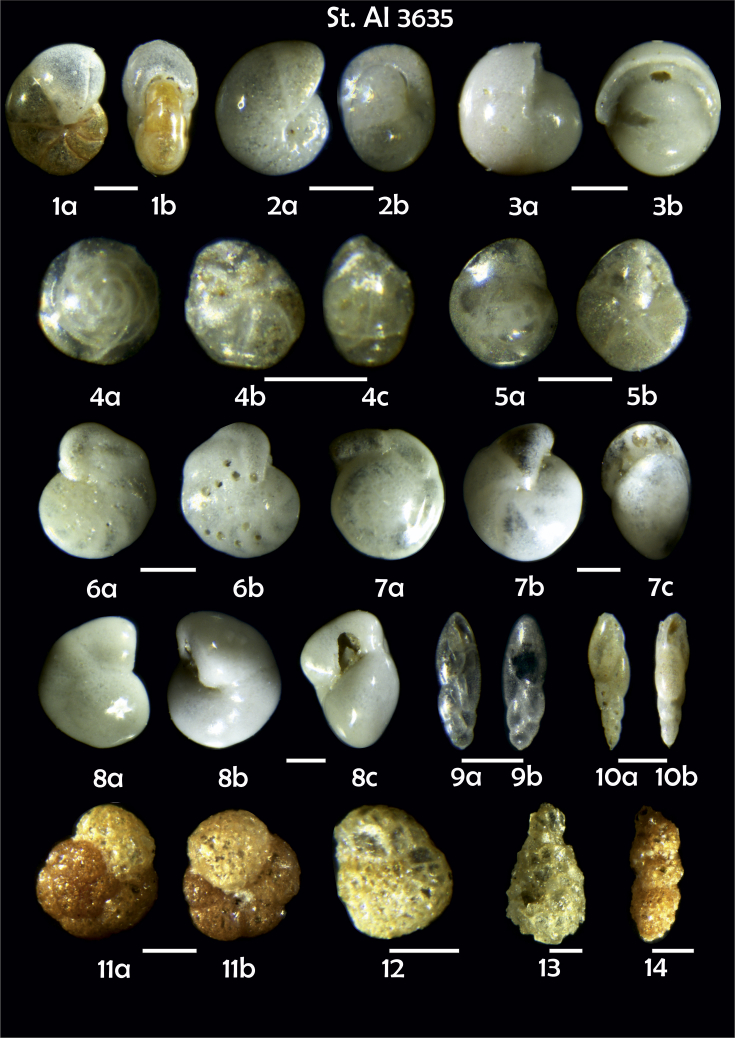
Station 36351Pullenia sp., a lateral view, b apertural view. 2Melonis pompilioides, a side view, b apertural view. 3Pullenia bulloides, a side view, b apertural view. 4Alabaminella weddellensis, a spiral view, b umbilical view, c lateral view. 5Epistominella exigua, a spiral view, b umbilical view. 6Cibicidoides wuellerstorfi, a umbilical view, b spiral view. 7Oridorsalis umbonatus, a spiral view, b umbilical view, c apertural view. 8Hansenisca? sp., a spiral view, b umbilical view, c apertural view. 9, 10Fursenkoina complanata, 9a apertural view, 9b lateral view, 10a lateral view, 10b apertural view. 11Trochammina inflata, a spiral view, b umbilical view. 12 ?. 13Lagenammina difflugiformis. 14Karrerulina conversa. Scale 100 μm.